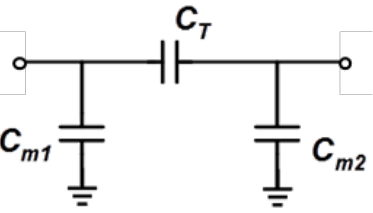
Figure 4. Low-frequency equivalent circuit model of the passive diode .